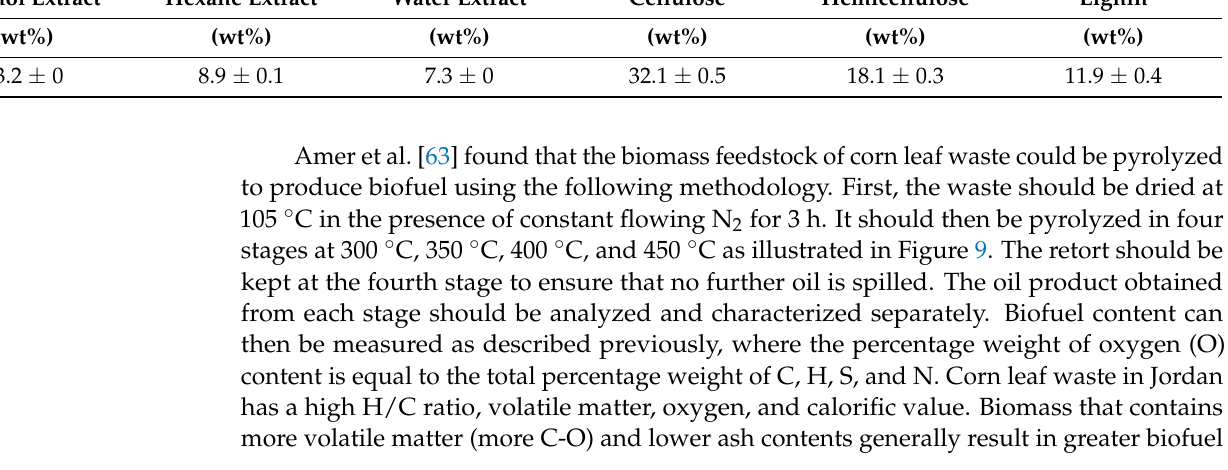
Figure 8. General bioenergy production scheme.